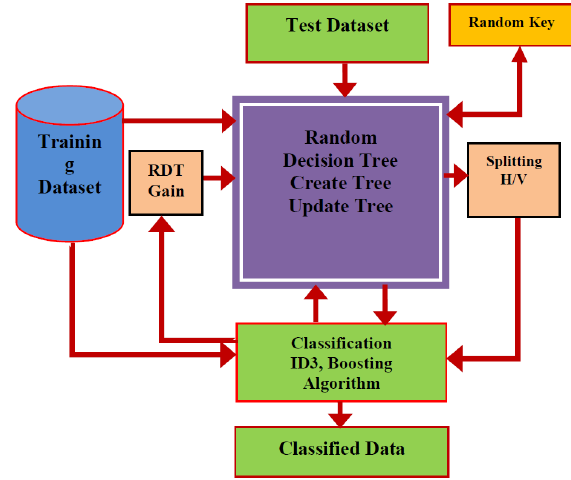
Fig. 1. Random Decision Tree